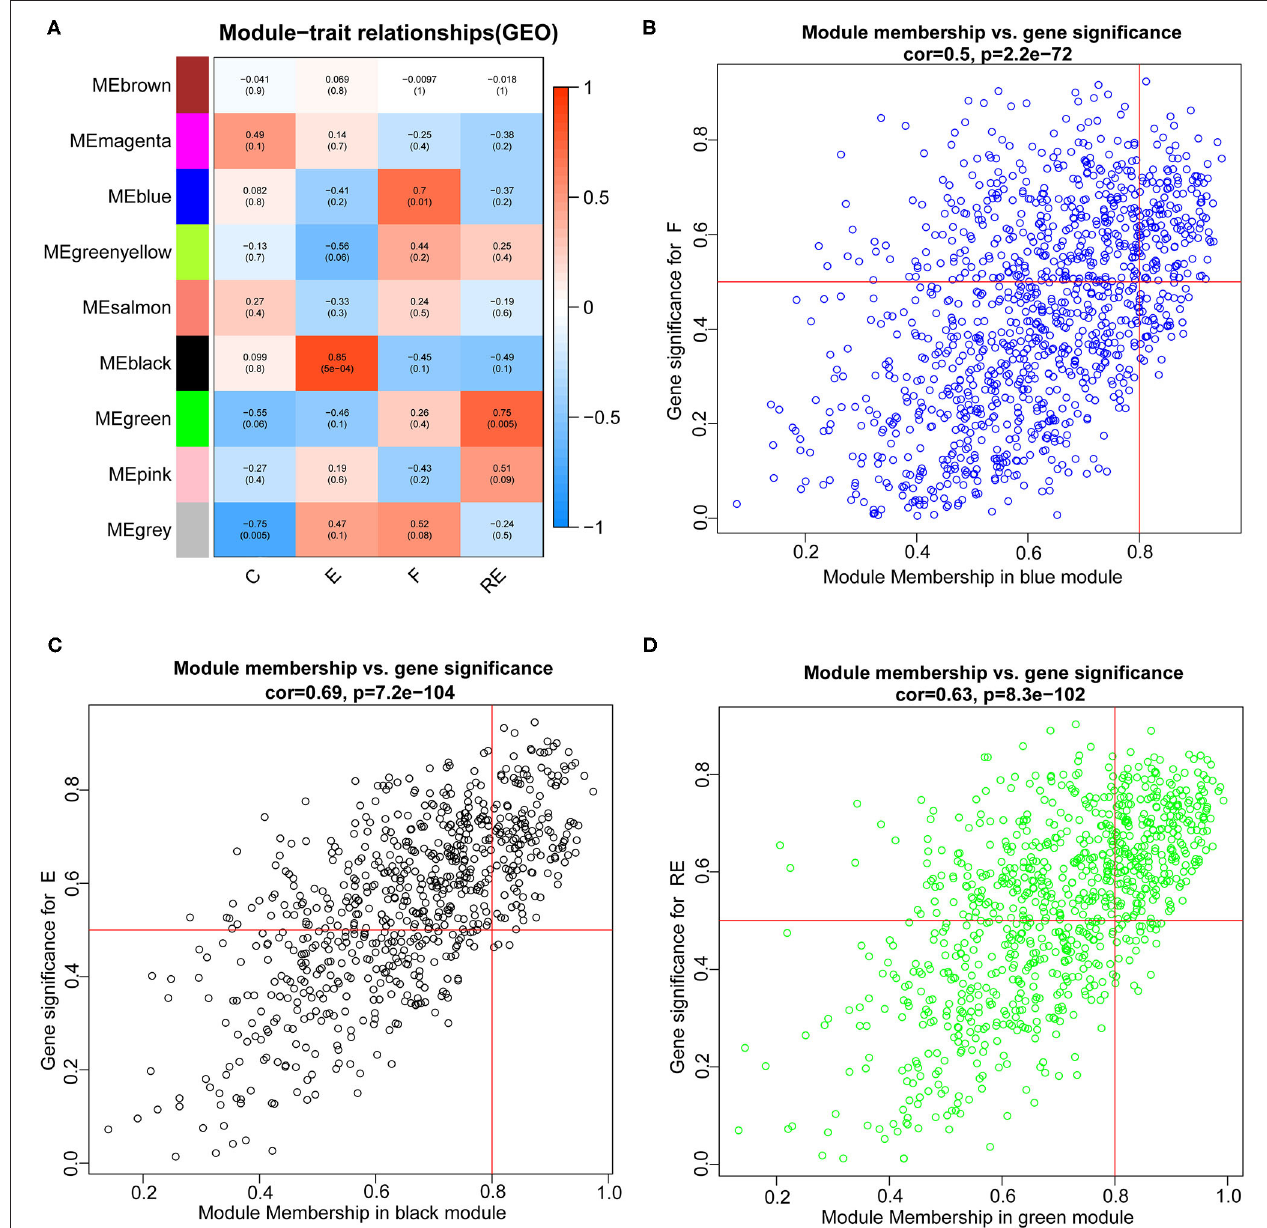
FIGURE 5 | Identification of modules associated with the F, RE, and E in mice. (A) Heatmap of the correlation between the module and F, RE, and E in mice. We selected blue, black, and green modules for subsequent analysis. Scatter plot analysis of modules in the blue (B) , black (C) , and green (D) modules. = 0.69, p = 7.2e − 104), and RE (cor = 0.63, p = 8.3e −